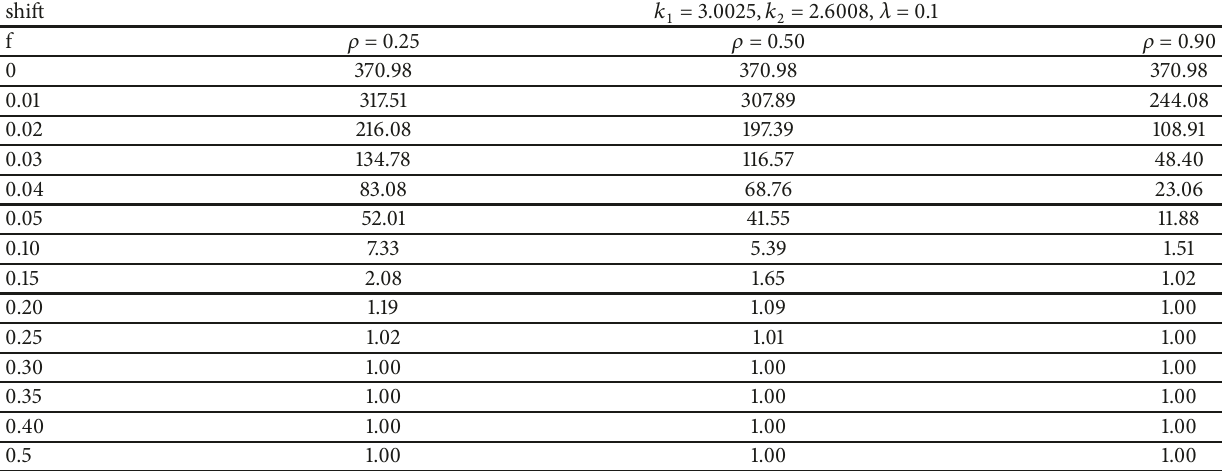
Table 4: ARLs for proposed repetitive EWMA-RSS control chart using Bahl and Tuteja (1991) exponential ratio-type estimator, when 𝑟 𝑜 is 370.